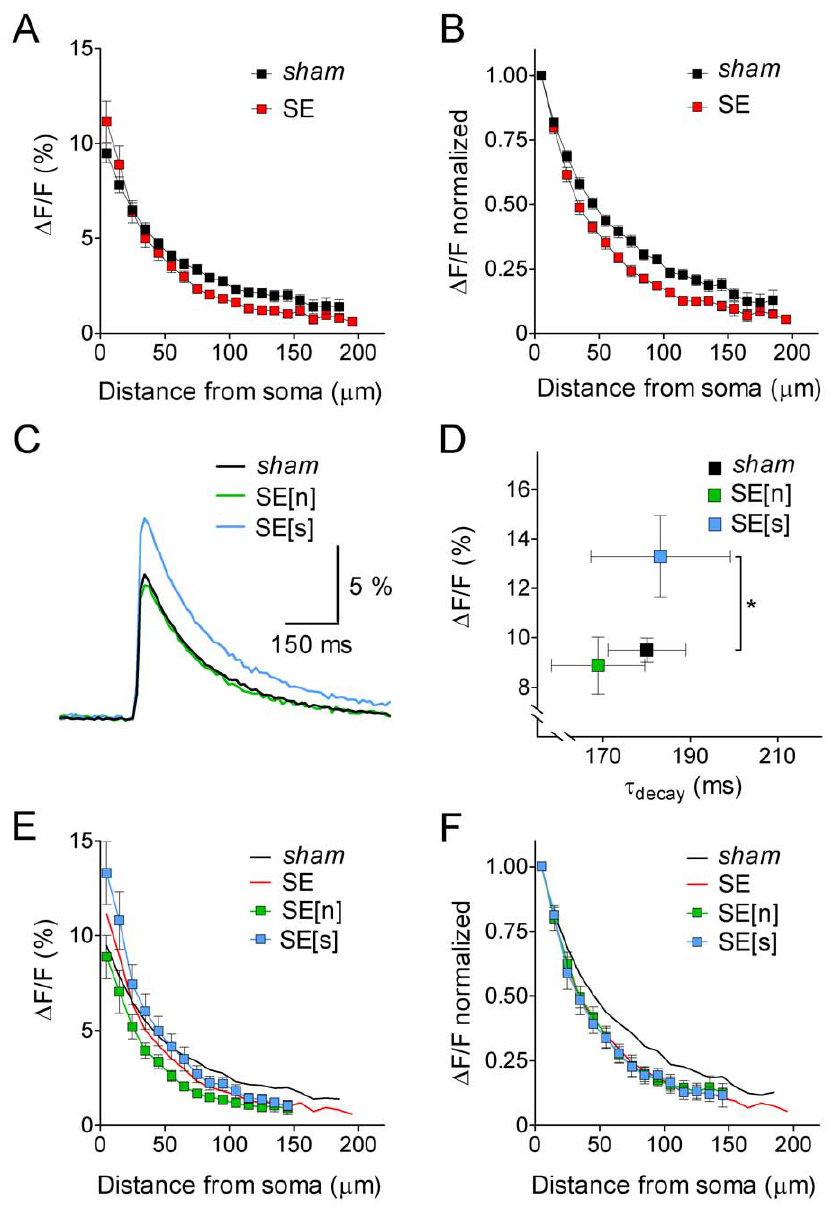
Figure 6. Quantitative analysis of the dynamics of b-AP-induced Ca 2 + signals in CA1 pyramidal cells. A . Maximal fluorescence changes ( D F/F in %) along the apical dendrite (10 m m steps, starting 5 m m from the soma) for sham (black, n=41 continuous data sets averaged) and SE cells (red, n=39 continuous data sets averaged). Ca 2 + signals in the proximal dendrite were slightly larger, but the overall attenuation of the b-AP-induced Ca 2 + signal along the apical dendrite was stronger in SE versus sham cells (cross-over of data sets at 25 m m from the soma). B . B-AP imaging data normalized to the signal next to the soma for sham (black, n=41) and SE cells (red, n=39). C . Averaged Ca 2 + signal traces next to the soma for sham (black, n=41), SE[n] (green, n=17) and SE[s] cells (blue, n=12). D . Comparison of Ca 2 + signal amplitude and decay kinetics measured next to the soma for sham (black, n=41), SE[n] (green, n=17) and SE[s] (blue, n=12); * p , 0.05. E . B-AP analysis ( D F/F in % along the apical dendrite) for SE[n] (green, n=17) and SE[s] cells (blue, n=12); lines without symbols represent corresponding data from sham (black) and the parent population of SE cells (red; see panel A). F . Normalized b-AP imaging data for SE[n] (green, n=17) and SE[s] cells (blue, n=12); lines without symbols represent corresponding data from sham (black) and the parent population of SE cells (red; see panel B). Note that SE[n] and SE[s] data superimpose with parent SE data when normalized. doi:10.1371/journal.pone.0026664.g006 caused a dramatic increase in the mean signal amplitude at all range for Ca 2 + signal detection, whereas 4-AP allowed the detection locations along the dendrite, with 27.2 6 3.0% (n=15) next to the of Ca 2 + signals still at larger distances (more than 250 m m) from the soma and 9.9 6 0.8% (n=2) at a distance of 255 m m (Fig. 8A). The soma. Under control conditions the signal amplitude ( D F/F) declined from 11.6 6 0.9% (n=36) next to the soma to 1.8 6 0.4% (n=6) at a normalized summary data are shown in Figure 8B. A clear distance of 225 m m, and with NS5806 from 12.6 6 0.7% (n=15) next strengthening of the normal attenuation of the b-AP-induced Ca 2 + to the soma to 1.1 6 0.01% (n=2) at a distance of 185 m m. 4-AP signal, especially within a range of 50–120 m m from the soma, can be